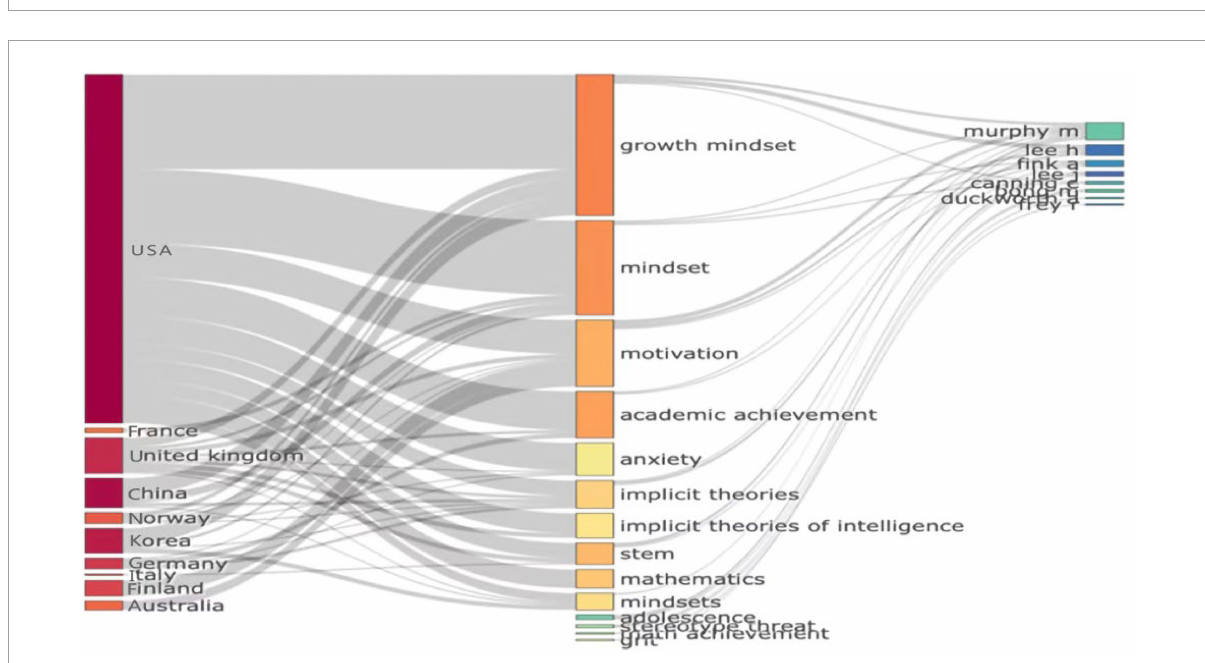
FIGURE3 Three-field plot for countries of publications, keywords in abstracts, and authors.